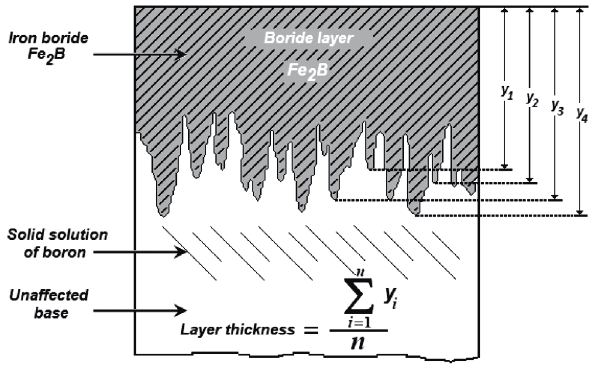
Fig. 4: A Schematic illustration showing the procedure used to estimate the Fe 2 B layer thickness on AISI 1026